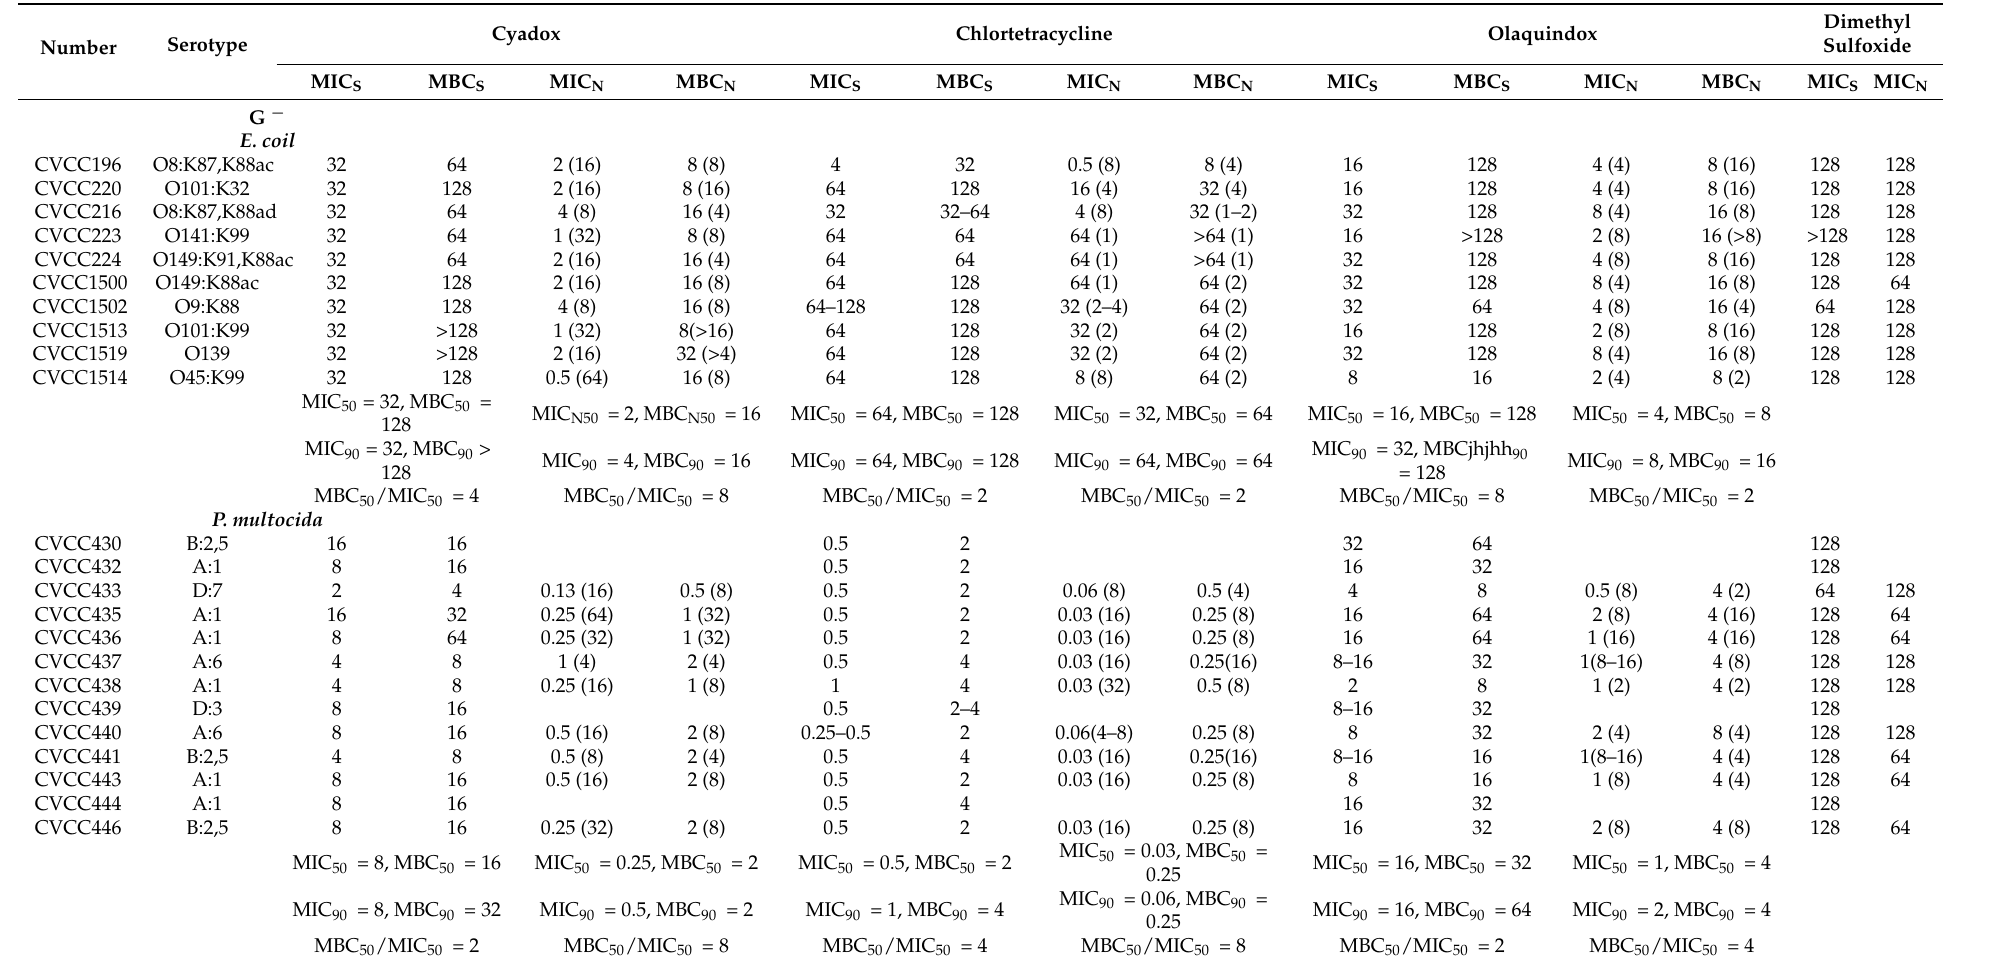
Table 1. Antimicrobial susceptibility of cyadox and controls against pathogens isolated from pigs (unit: µ